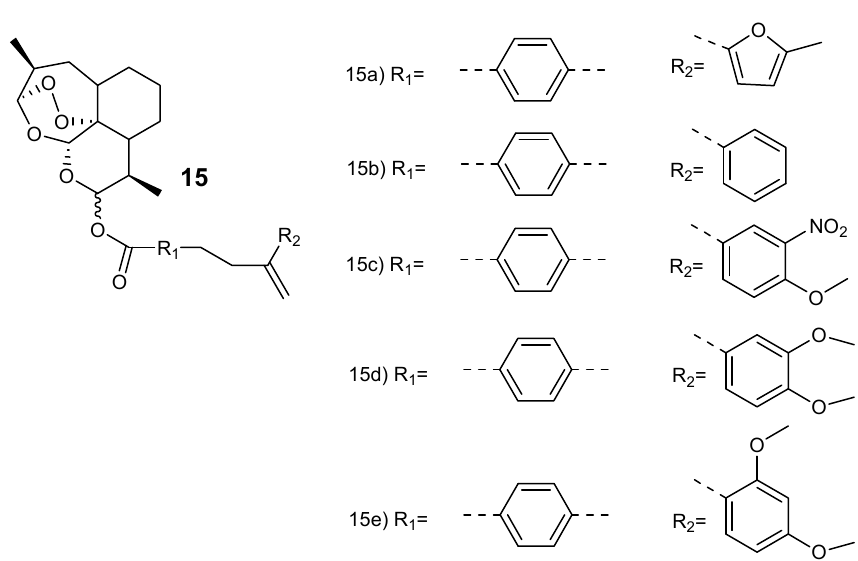
Figure 3. Dihydroartemisinyl-chalcone hybrid compounds 15 .